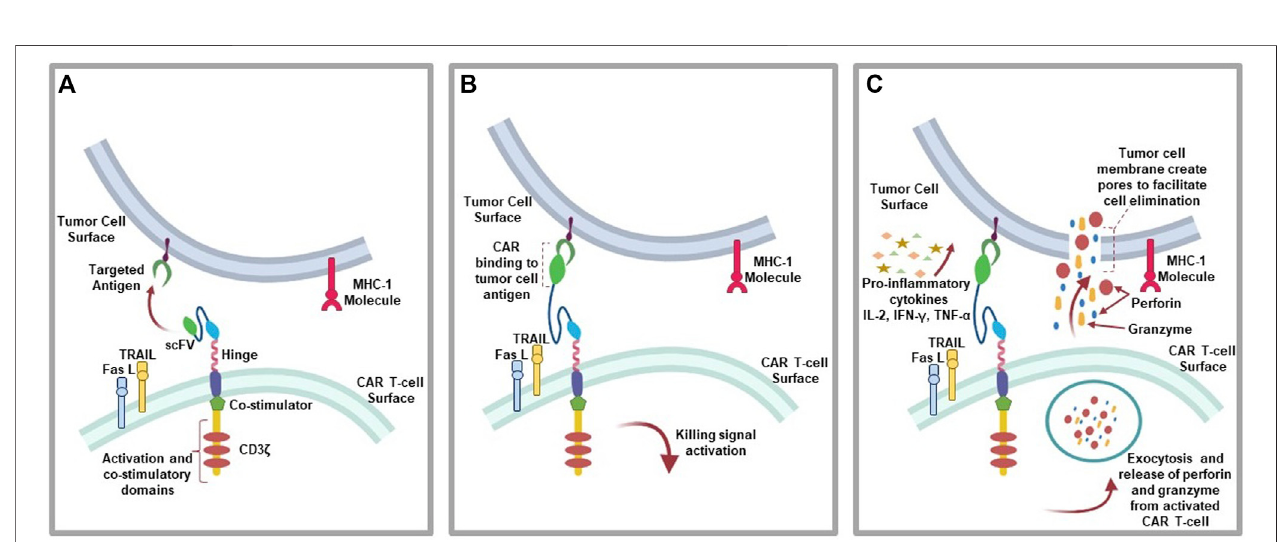
FIGURE3| CART-cellaction: (A) CART-cellsrecognitionoftargetedantigen. (B) Chimericantigenreceptorbindingtotumor-antigen. (C) Initiationoftheantitumor (cytolytic) effects where the activated T-cells downstream the killing signaling by secreting granzymes and perforins, pro-in fl ammatory cytokines due to immune cell invasion, as well as initiating the expression of TRAIL and FasL